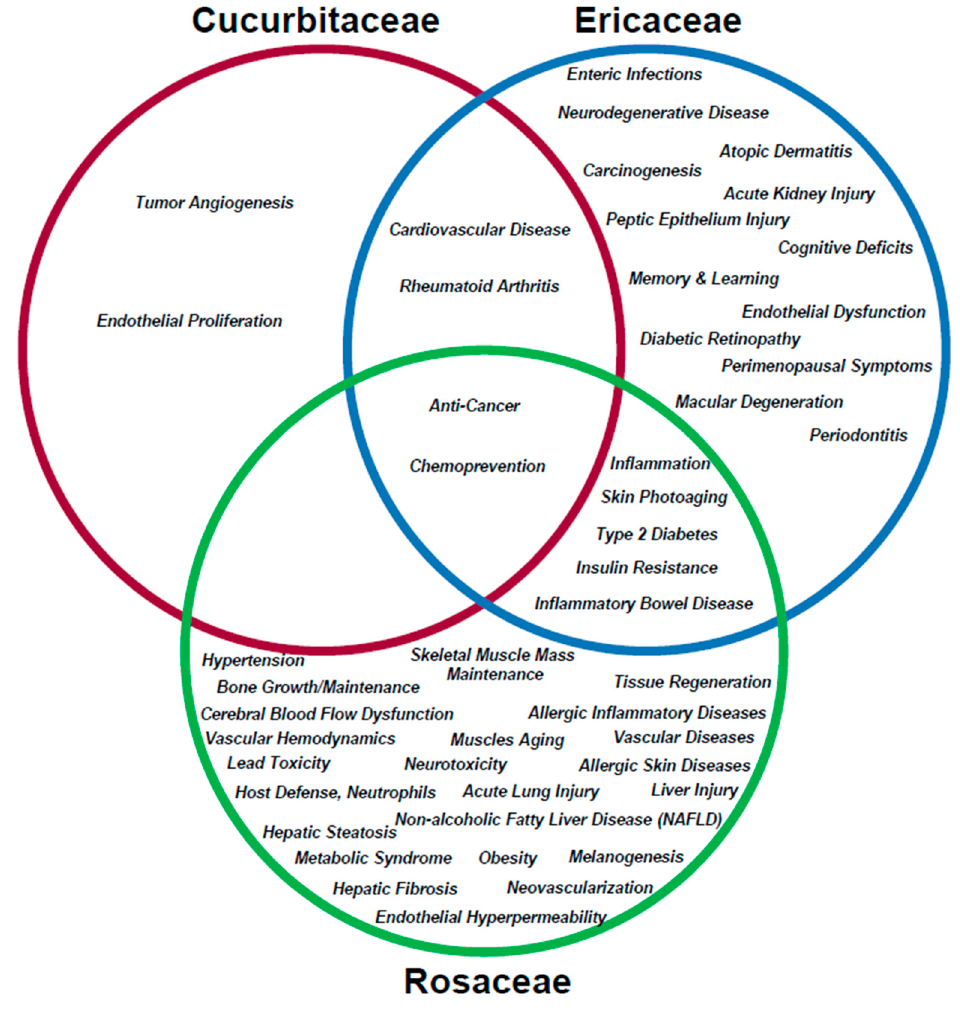
Figure 2. A Venn-diagram representation of the diseases in which metabolites from each plant family have been reported, with respect to the PubMed, searches performed.